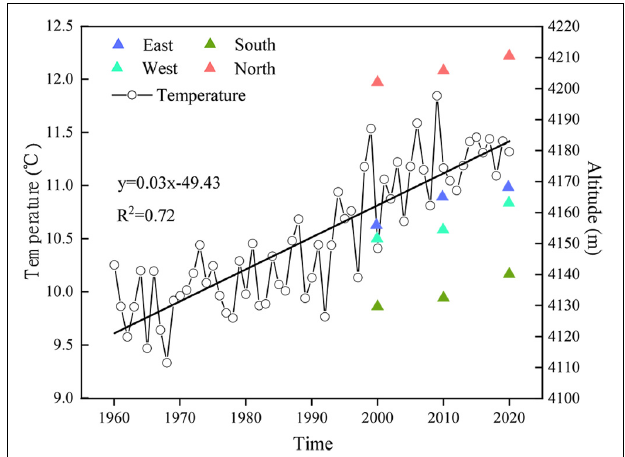
FIGURE 5 | Relationship between temperature change and treeline